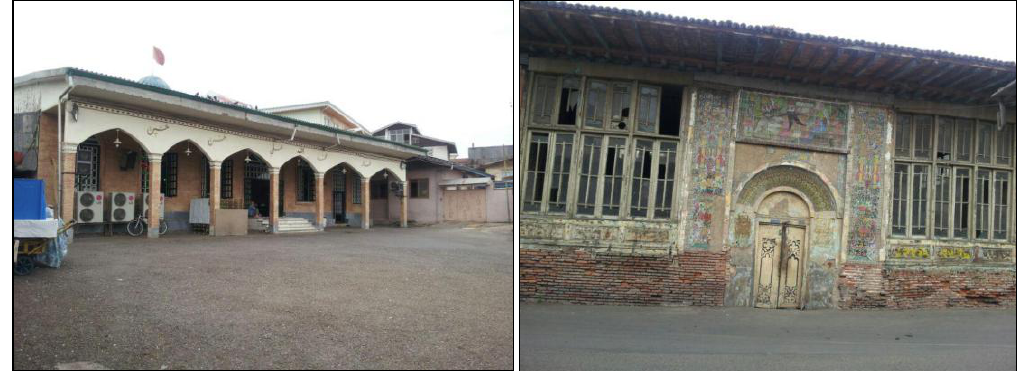
Figure 6. Agha Seyed Abbas Mosque Figure 7. Haji Bath